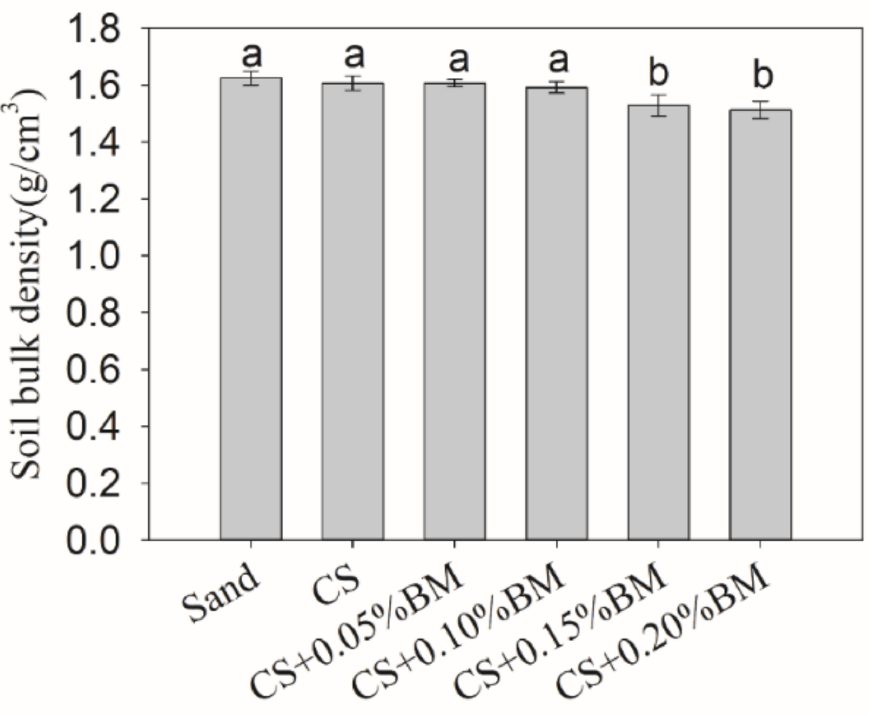
Figure 2. Effect of bacterial manure (BM) application on soil bulk-density. CS: complex soil from sandy soil and soft rocks. The BM was added in an m/m ratio. The different letters indicate significant difference ( p < 0.05). The percentage represents the mass ratio of BM